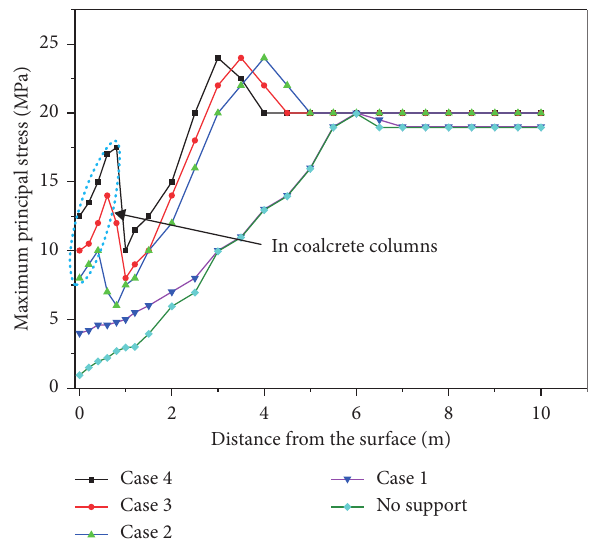
Figure 11: Maximum stress along the observation lines in sidewall under different